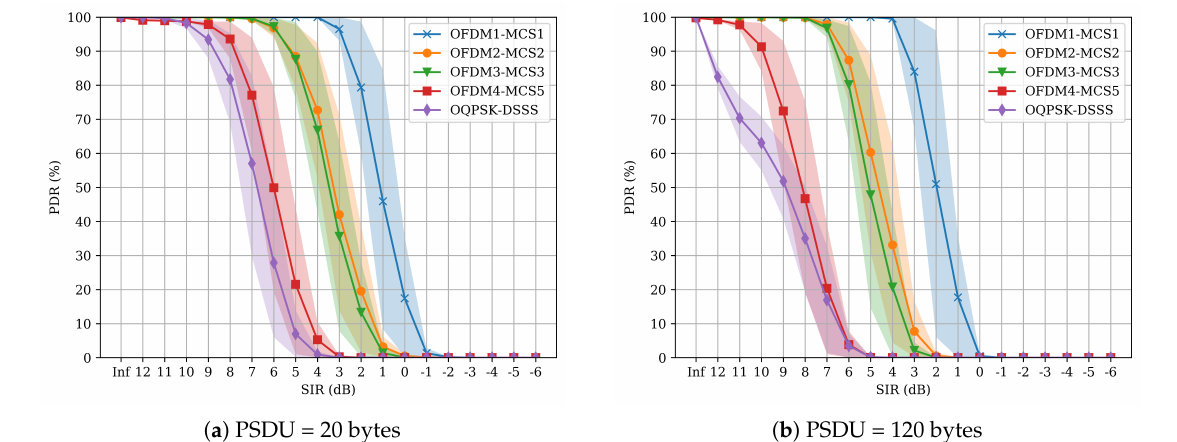
Figure 6. OFDM2-MCS2 interference results.